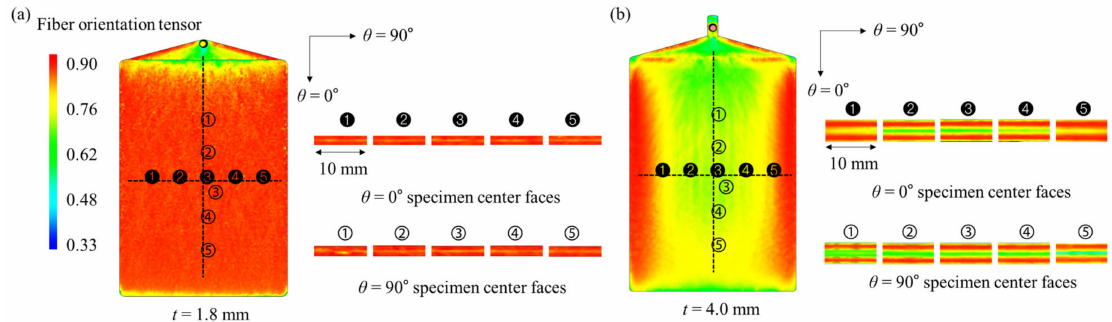
Figure 3. Results of the fiber orientation distribution from cut faces of the specimens from the plate of thickness t = ( a ) 1.8 mm, ( b ) 4.0